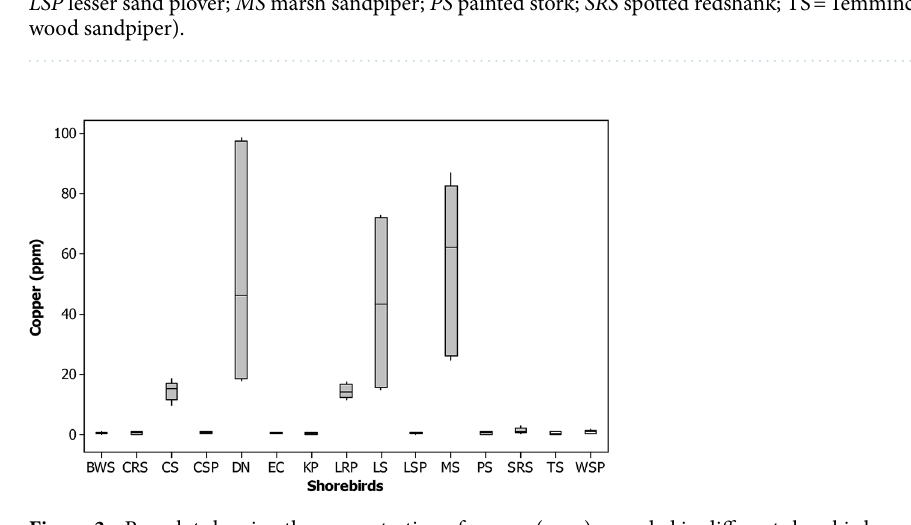
Figure 3. Box plot showing the concentration of copper (ppm) recorded in different shorebird species at Point Calimere Wildlie Sanctuary, Kodikkarai and Pichavaram Mangrove Forest, Pichavaram, east coast of Tamil Nadu,